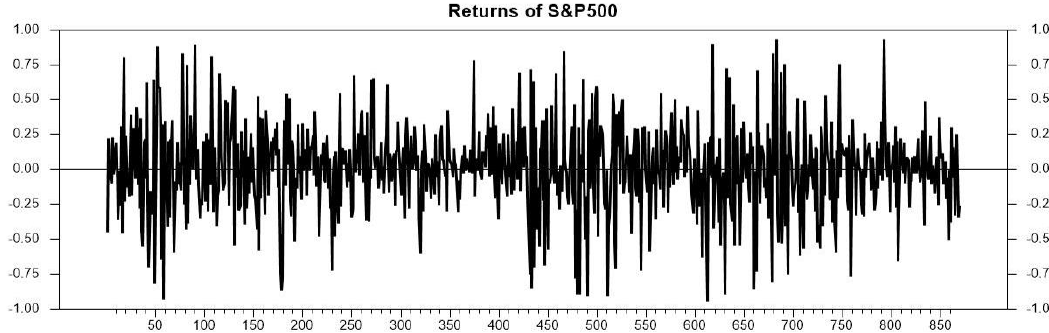
Figure 1. Returns of